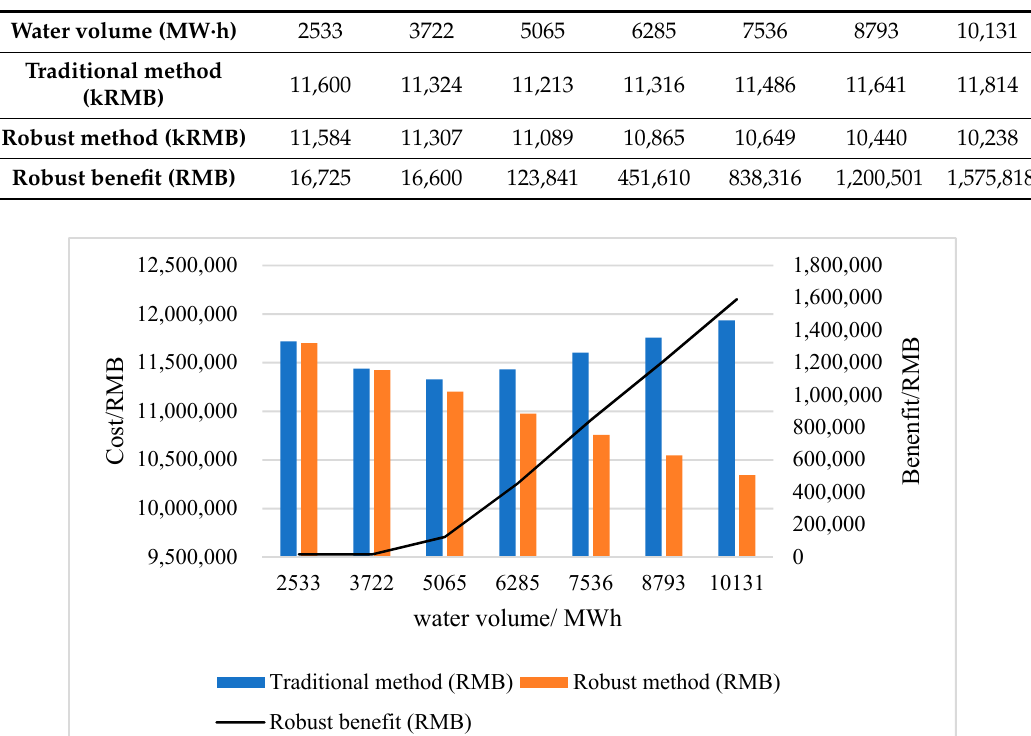
Table 6. Robustness benefits after water volume increases.